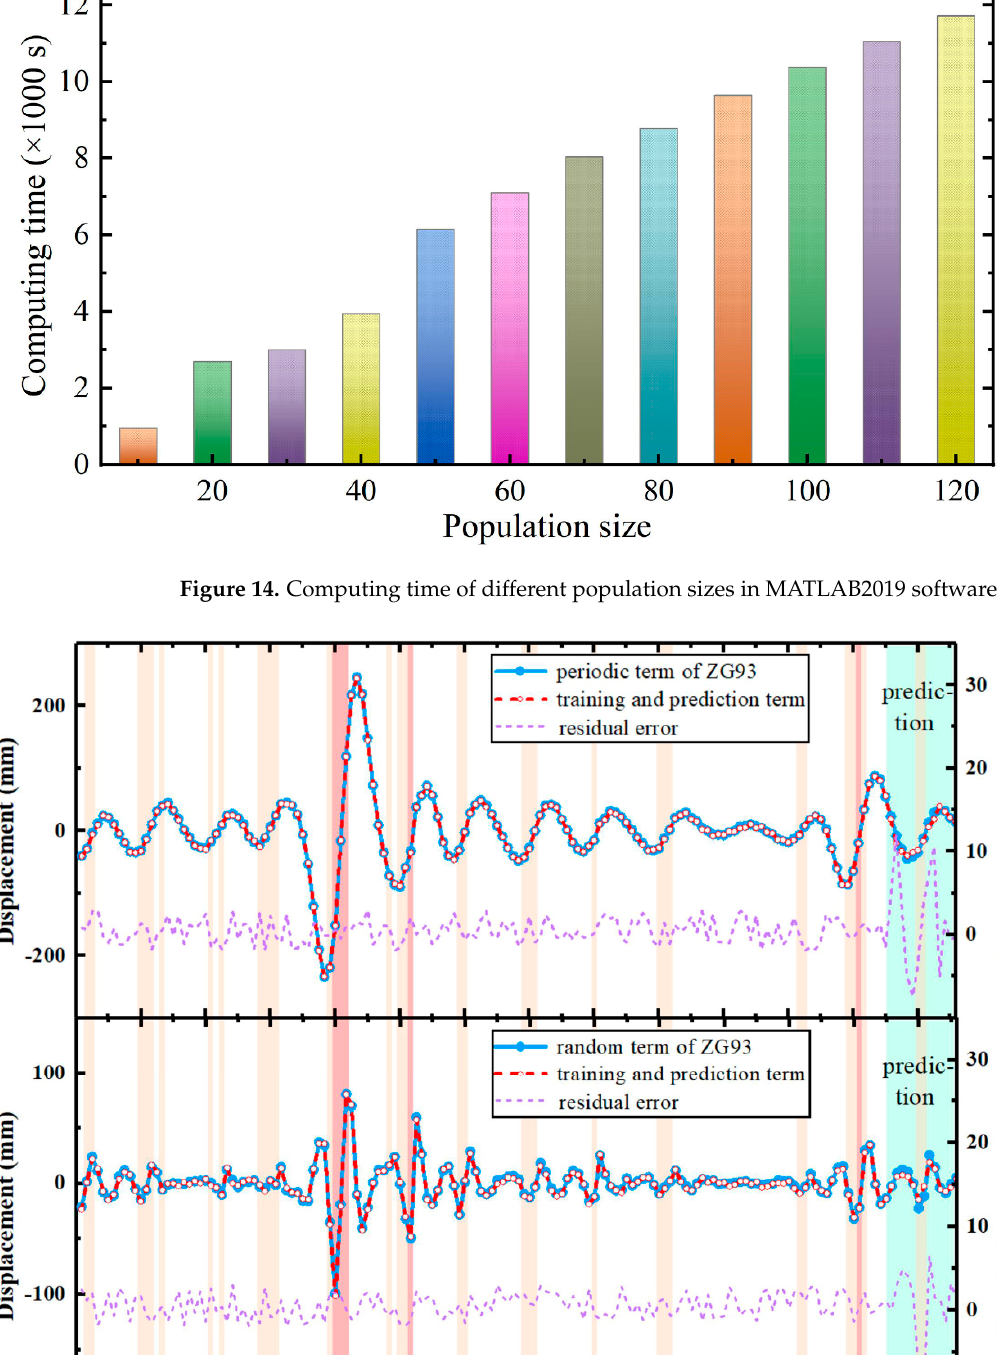
Figure 13. A population-based sensitivity analysis for the FOA-BPNN model.